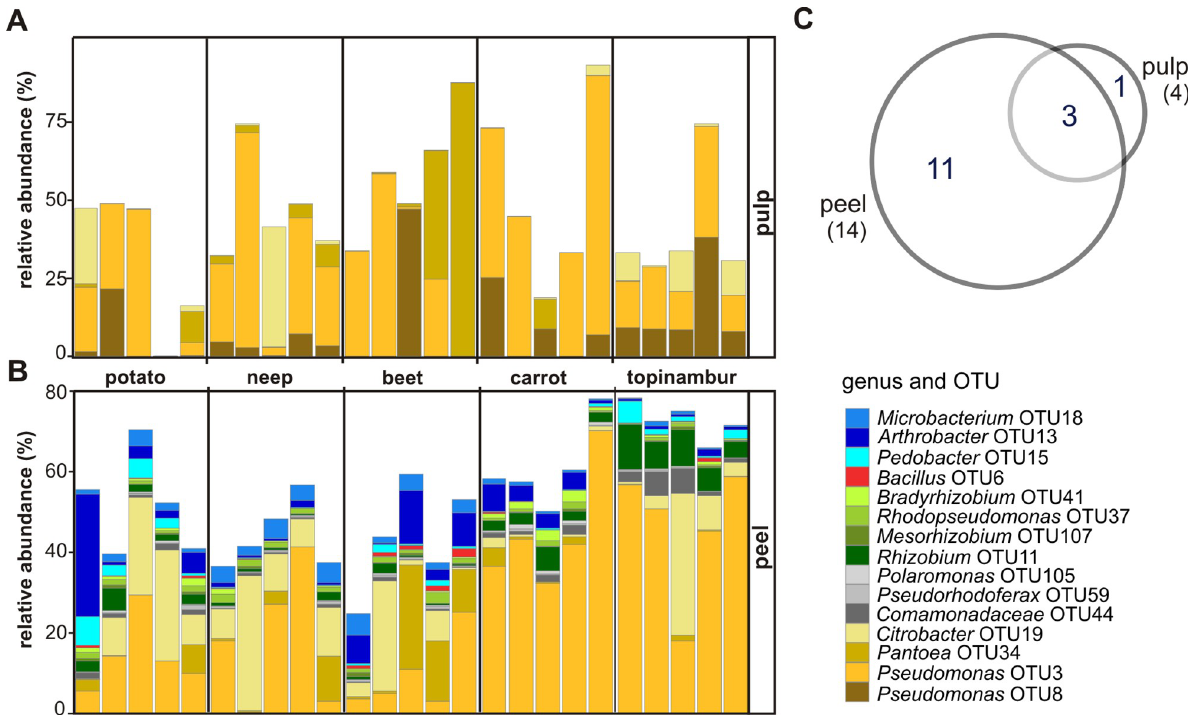
Fig 4. Relative sequence abundances of the core OTUs shared in the datasets of five root vegetables. The core OTUs of pulp (A) and peel (B) are shown. A Venn diagram shows the number of core OTUs shared between peel and pulp (C).